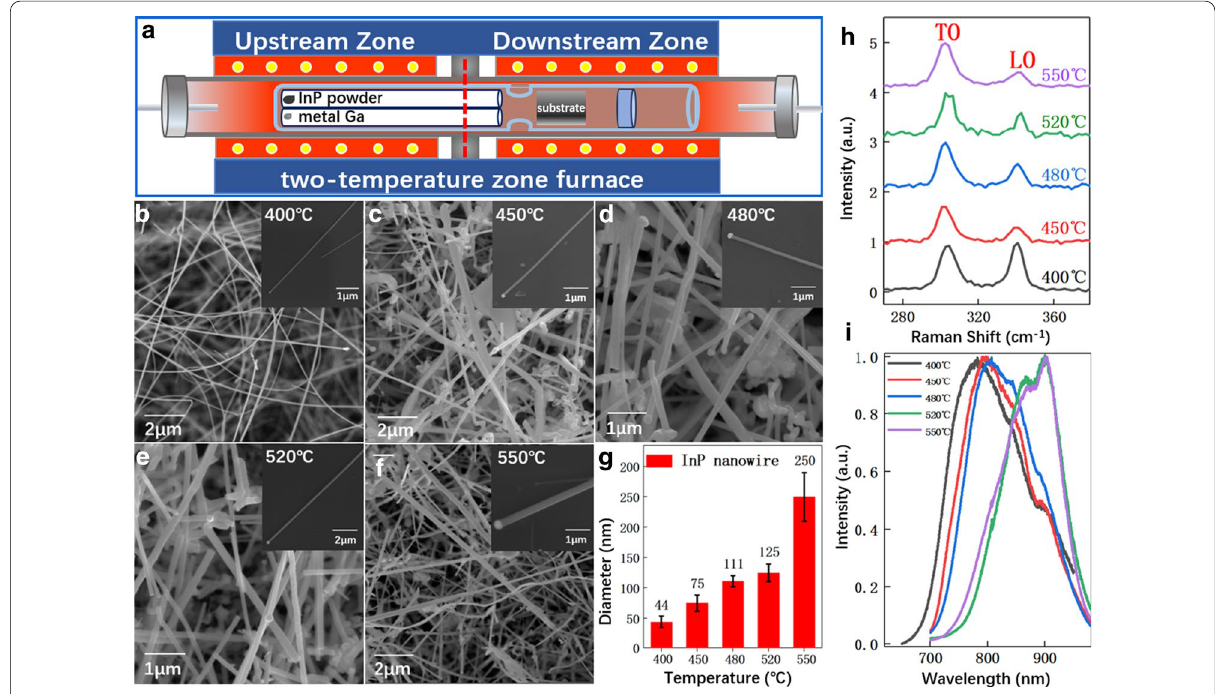
Fig. 1 Growth studies of InP nanowires. a Schematic illustration of the experimental setup for both InP and GaP nanowires growth. SEM images of InP nanowires grown at b 400 °C, c 450 °C, d 480 °C, e 520 °C and f 550 °C. g Diameter distribution of nanowires prepared at different temperatures. h Raman and i PL comparison of nanowires grown at different